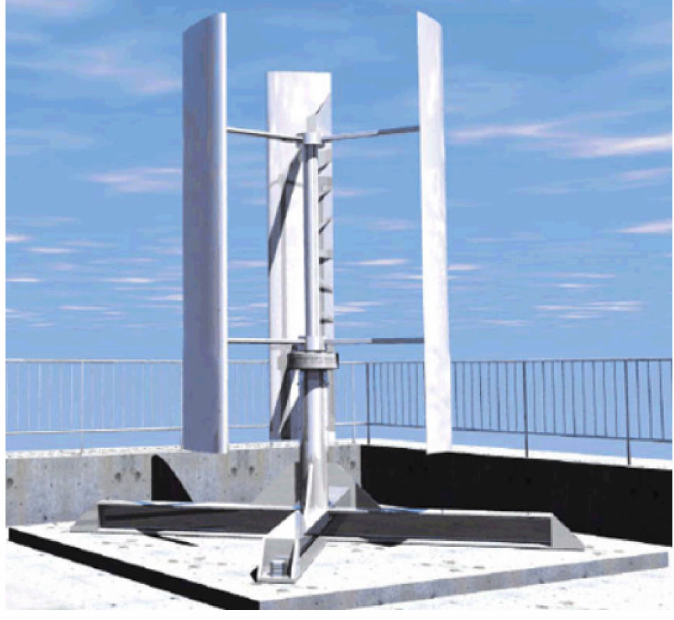
Figure 8. Roof mount towers.